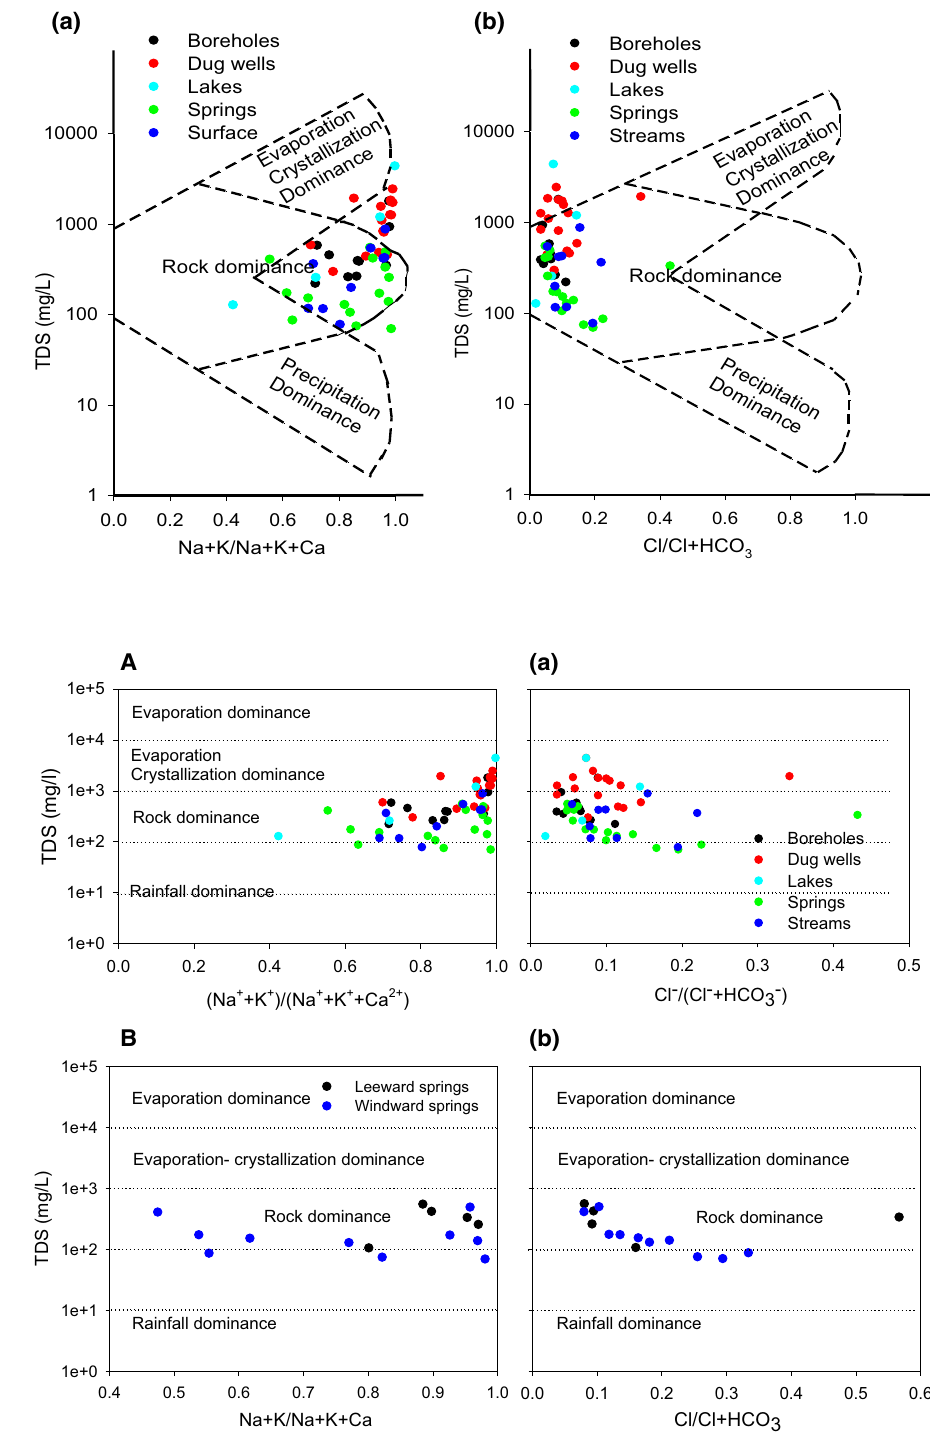
Fig. 19 Modified Gibb’s plot for groundwater from Meru district (After Narany et al. 2014)